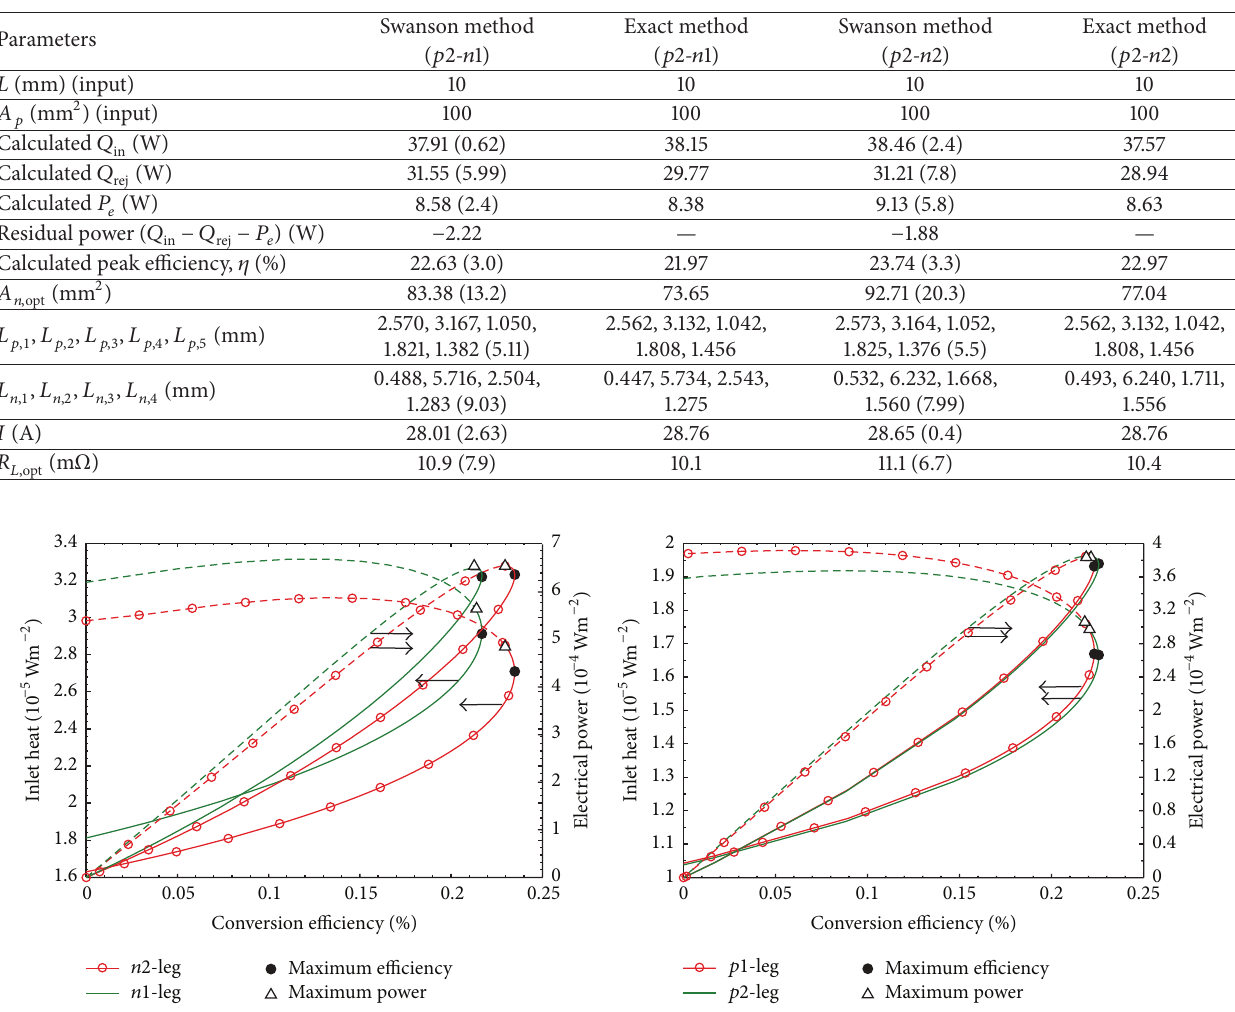
Table 3: Design and performance characteristics of 𝑝 2- 𝑛 1 and 𝑝 2- 𝑛 2 generators at maximum efficiency, calculated through both exact and Swanson et al.’s [13] methods. The differences of Swanson et al.’s results compared to the exact ones are shown in parenthesis. 𝐴 𝑝 and 𝐿 are assumed as constant inputs of the optimization process.